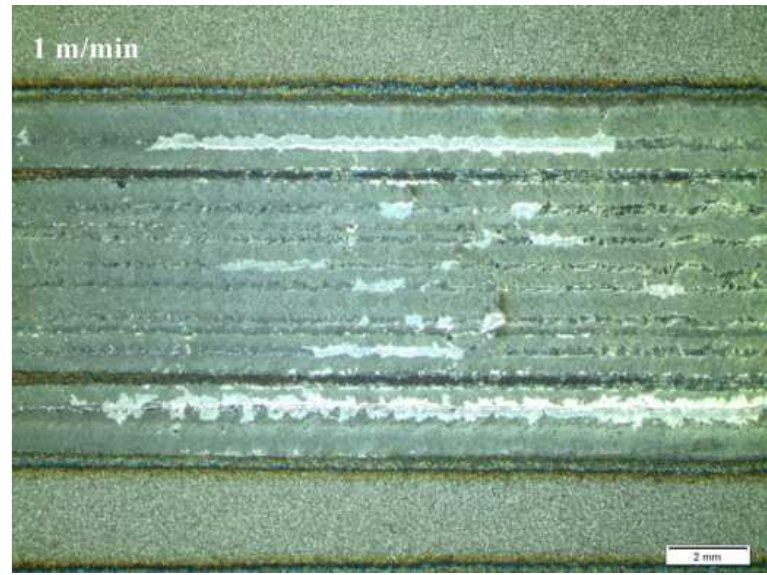
Figure 4. Morphology of the laser-alloyed tracks of surface of SSSs for sample 1.